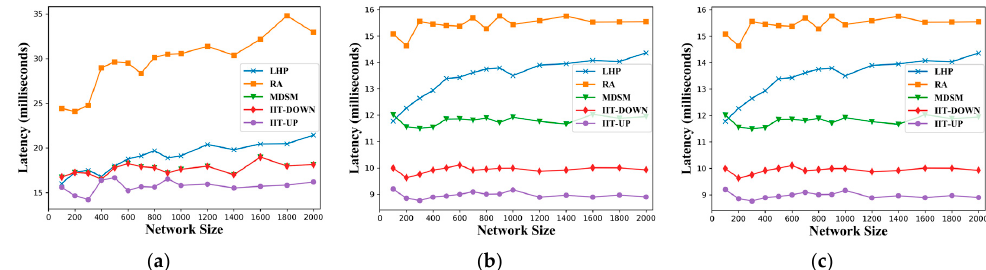
Figure 8. Average name-resolution latency at each layer. LHP provides a shorter average latency at the lowest level because it uses more name-resolution nodes. However, in higher-level layers, with the latency upper bound at 10 ms.